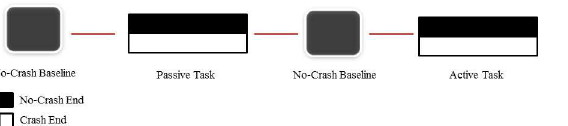
Fig 1. Experimental design. Passive or Active Task blocks were always presented after the Baseline condition. Blocks presentation was randomizedbetweensubjects. No-CrashEnd and Crash End conditions were randomized both in the Active and Passive